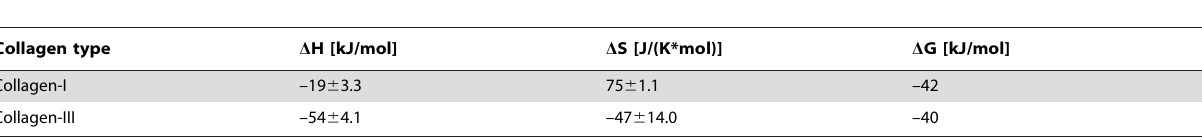
Table 3. Thermodynamic analysis of Simplagrin-collagen interaction measured by surface plasmon resonance.